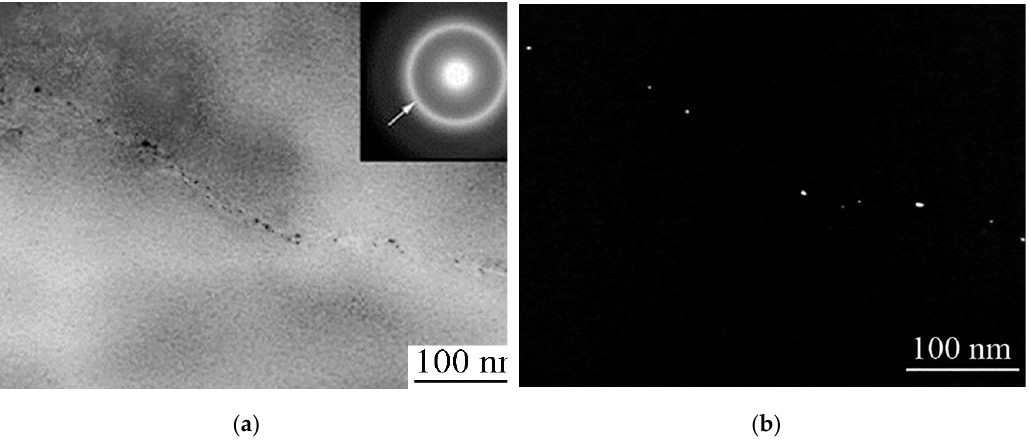
Figure 12. Microstructure of deformed Al 88 Ni 2 Y 10 sample (40%): ( a ) bright-field and ( b ) dark-field images.